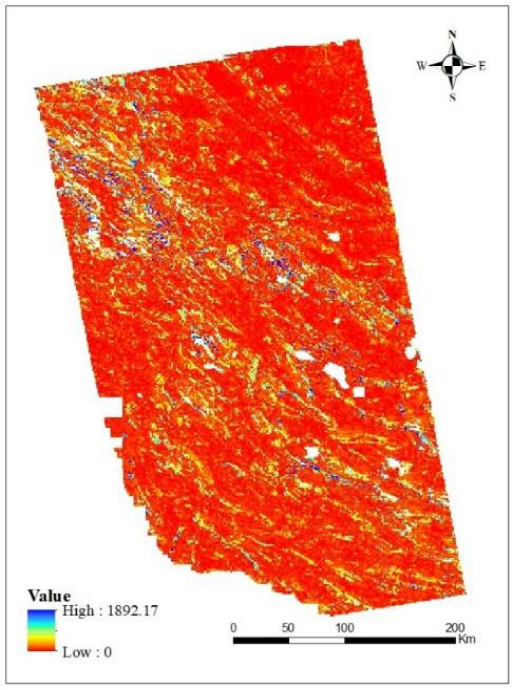
Figure 5 . Diagram of the mean absolute percent error (MAPE) in the whole Fars